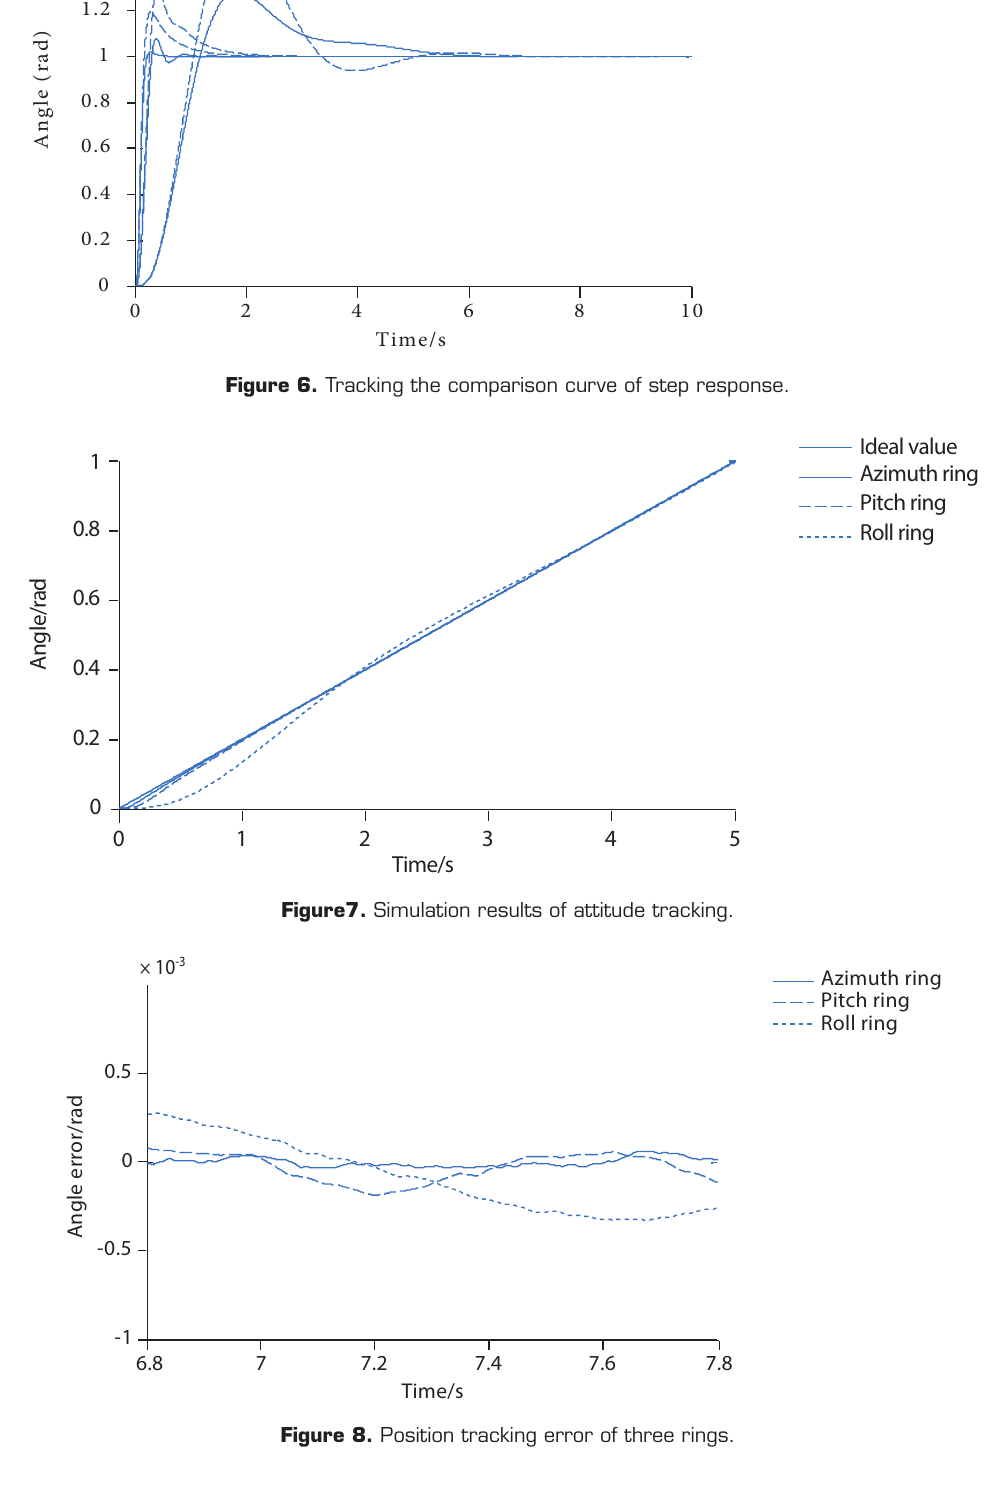
Figure 8. Position tracking error of three